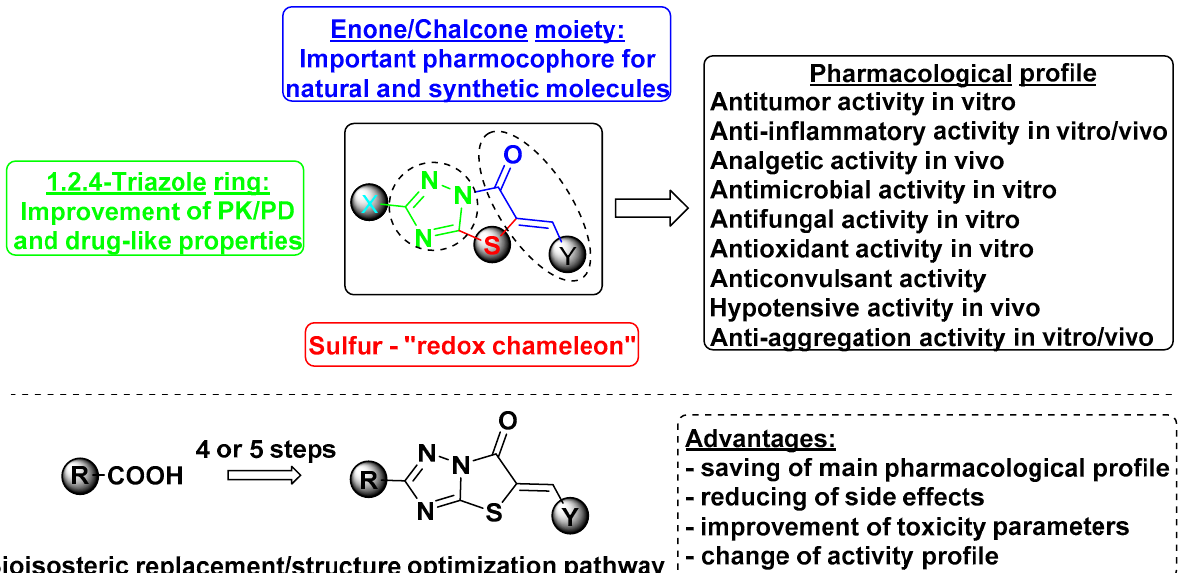
Figure 1. The current state of 5-ene-thiazolo[3,2- b ][1,2,4]triazole-6(5 H )-one bearing compounds in medicinal chemistry.